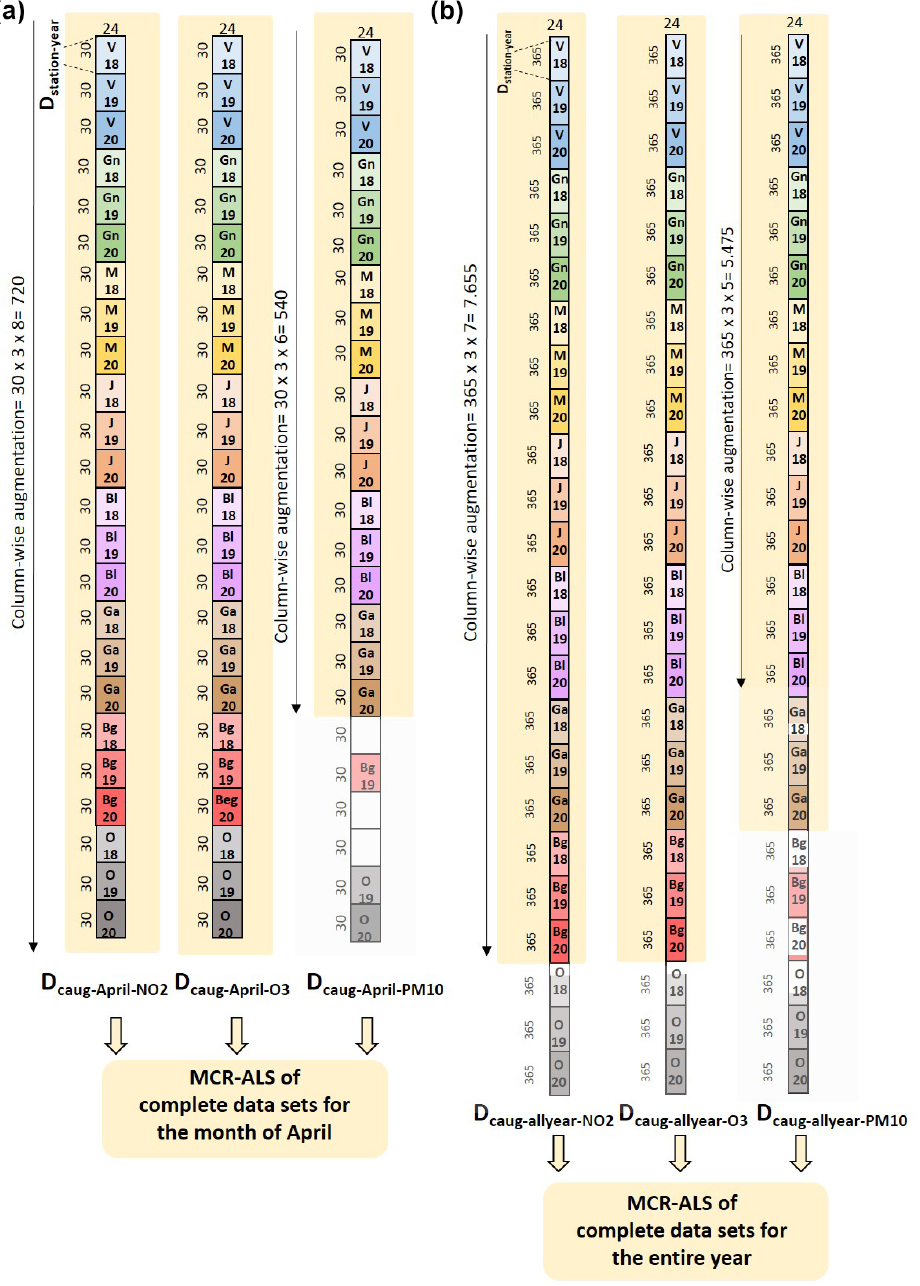
, D caug-April-O (720, 2 3 , 2